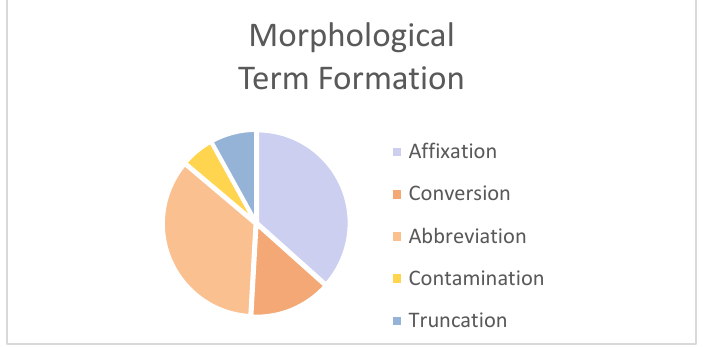
Figure 1 – Morphological Term